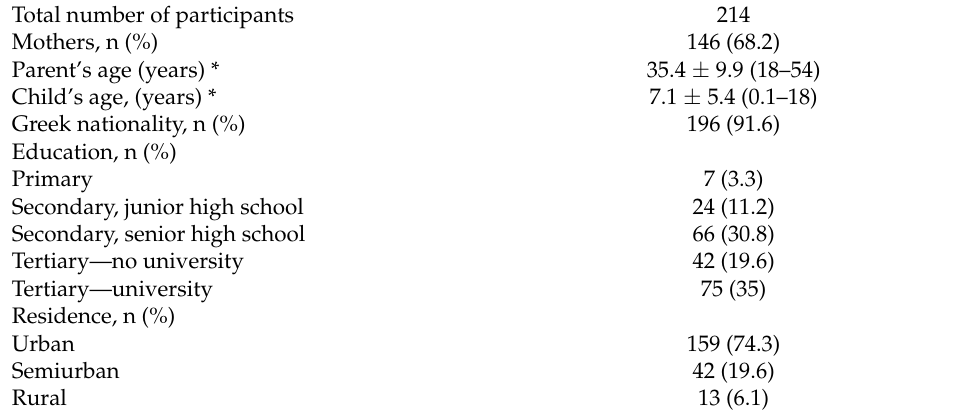
Table 1. Participants’ demographics.